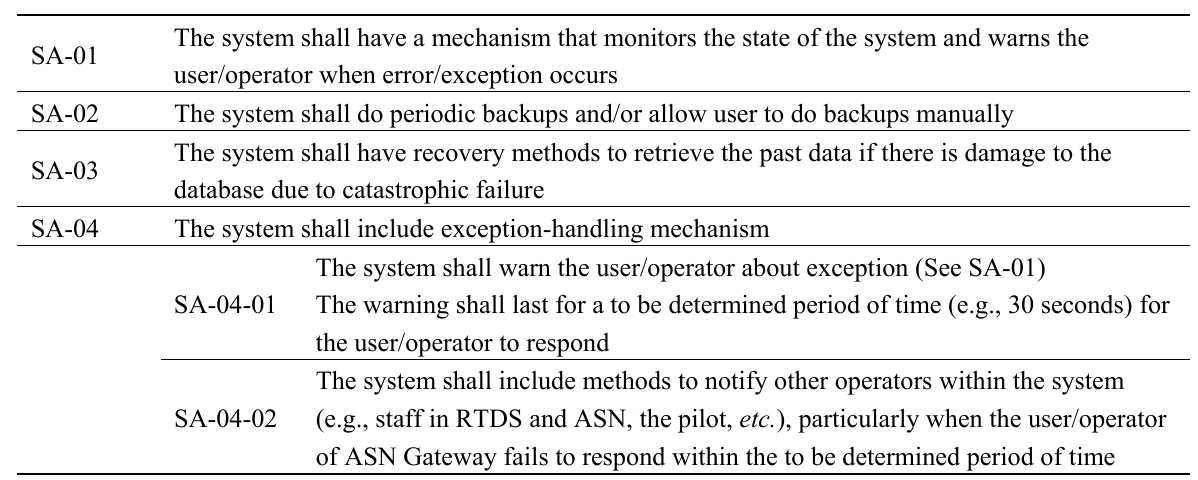
Table 2. ASN Gateway safety